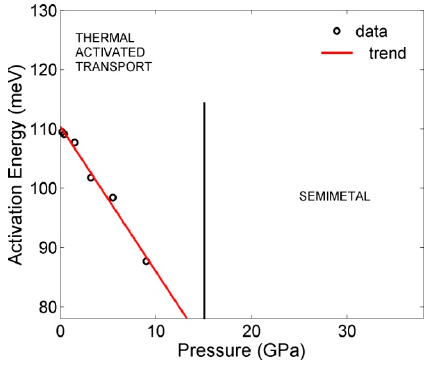
Figure 5. Calculated activation energy E A vs. P in the “low pressure” thermal activated regime of NaMn 7 O 12 (P < 15 GPa).